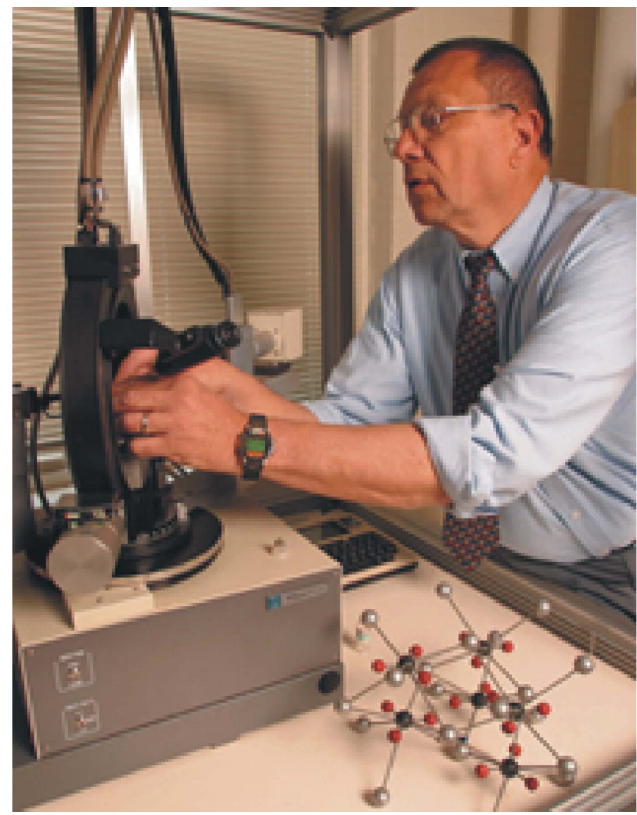
Figure 14 Jerry Jasinski